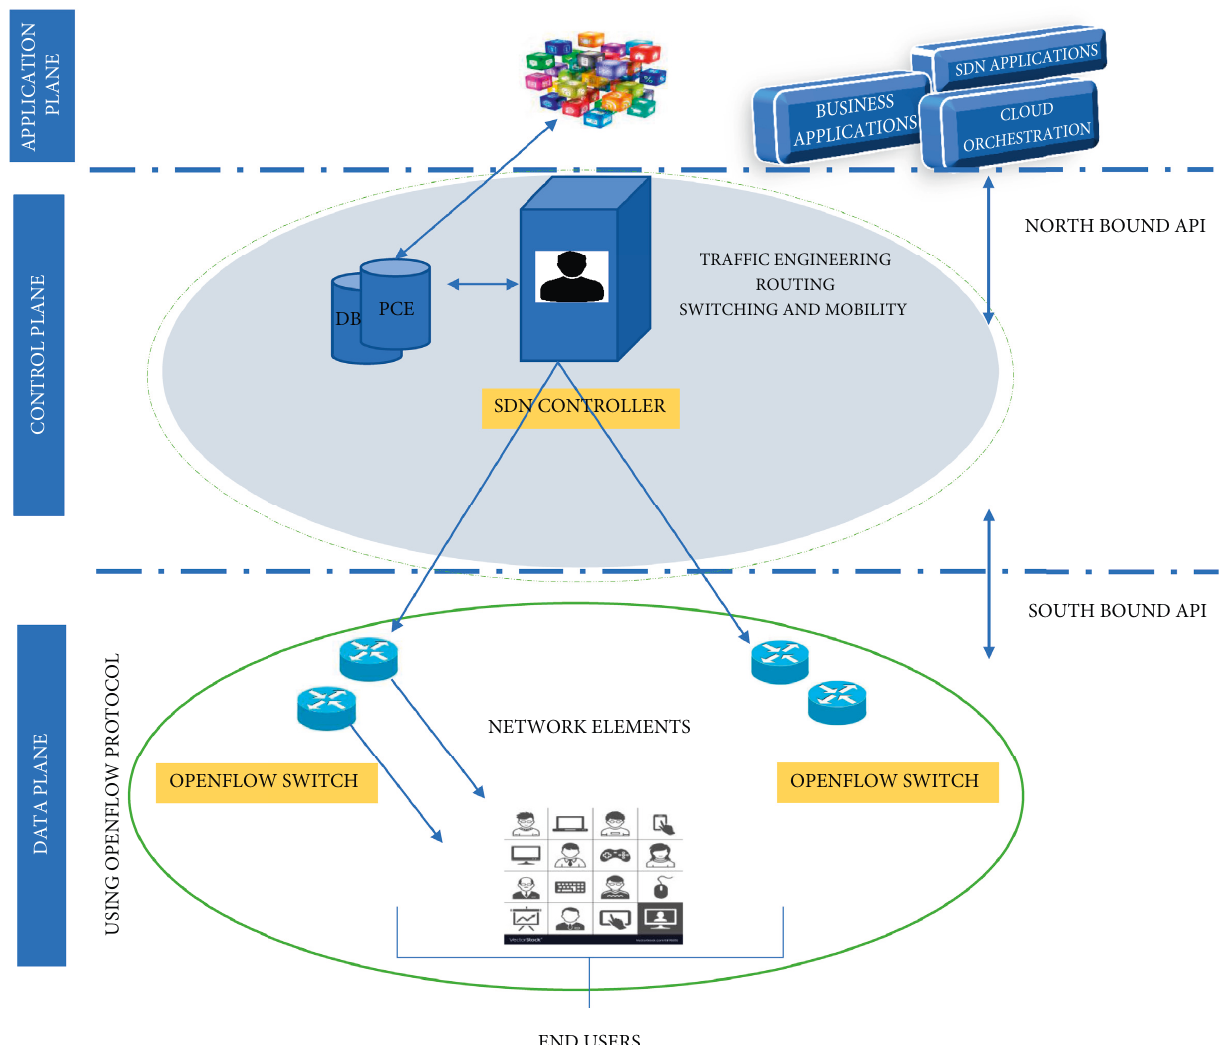
Figure 3: Architecture of software-defined